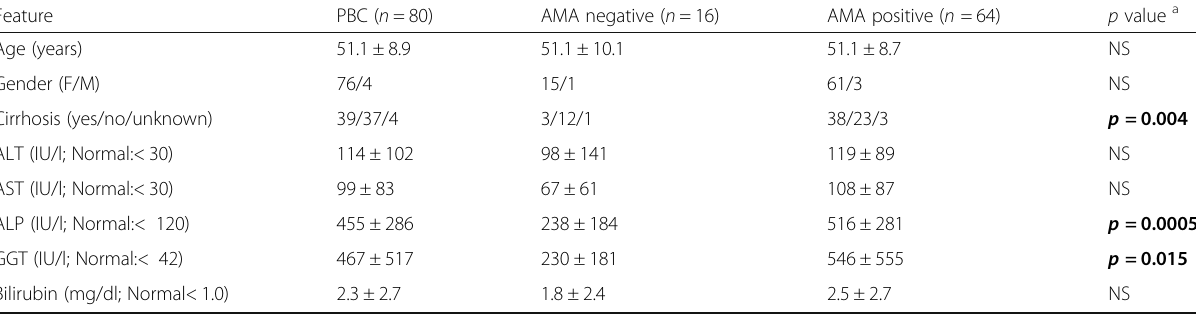
a p values: AMA-negative vs AMA-positive Bold entries have significant